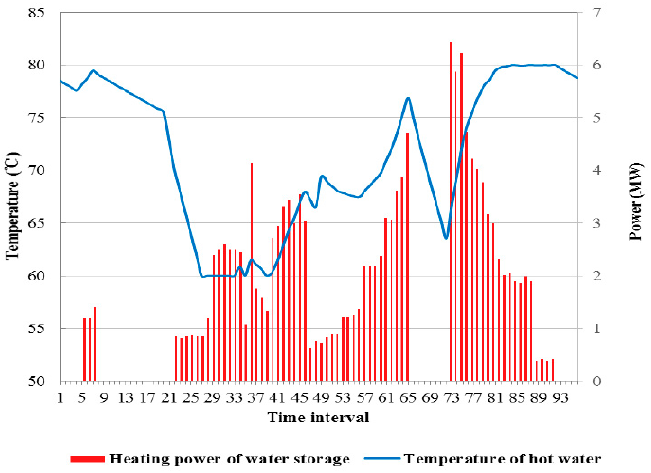
Figure 7. Shiftable electrical loads on a typical summer day.